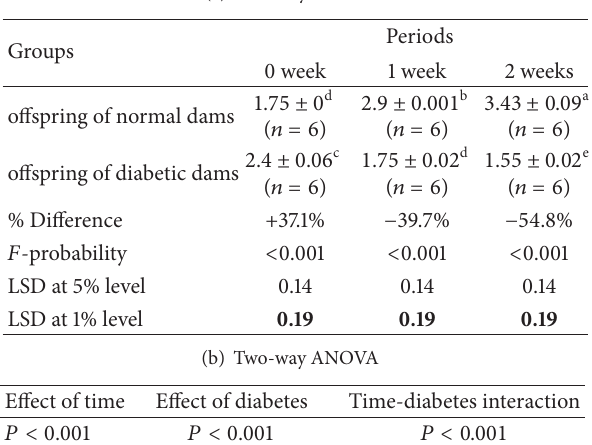
Table 2: Serum insulin concentration ( 𝜇 U/mL) of offspring of nor- mal and diabetic dams at different experimental